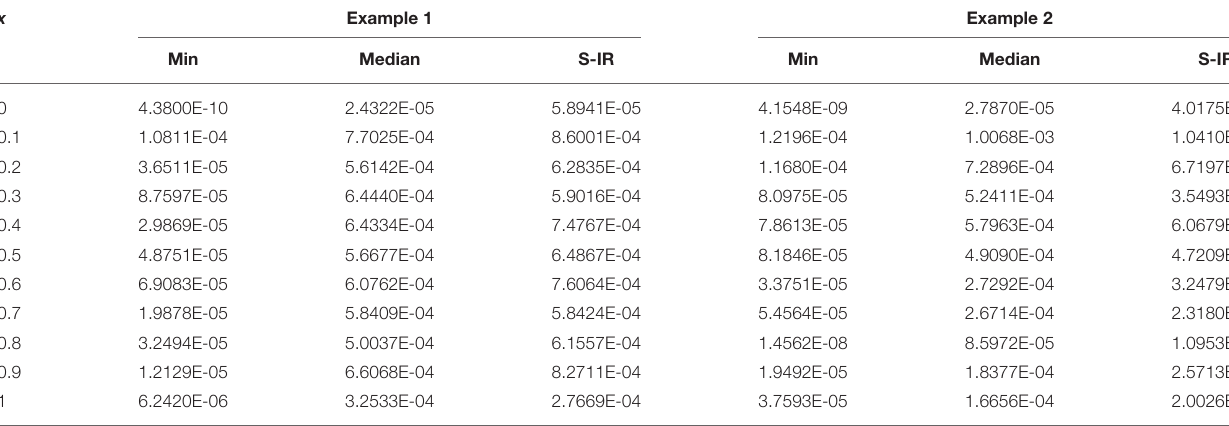
TABLE 2 | Statistical measures of second order NSP-BVPs for 5 numbers of neurons.